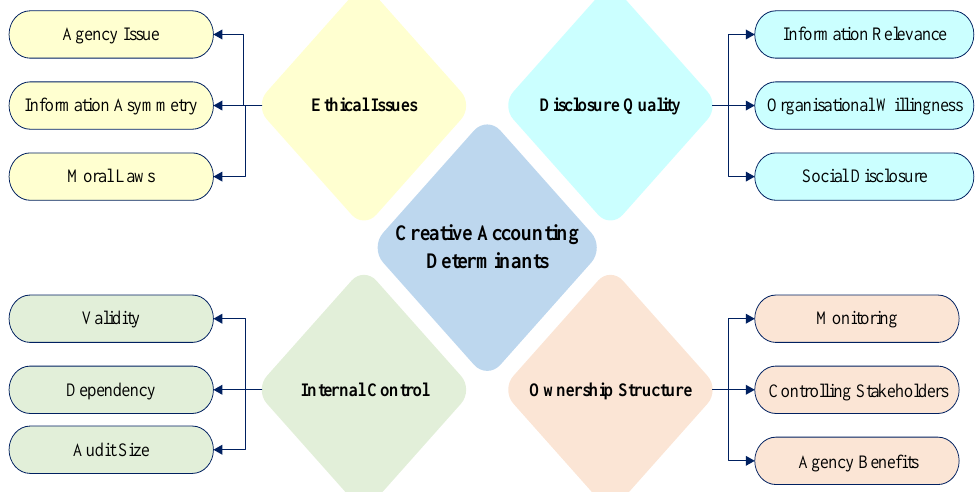
Figure 4. Structure of creative accounting determinants. Source: Own elaboration.